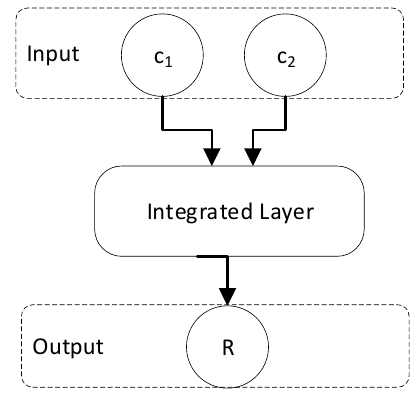
Figure 6. Structure diagram of the integrated layer.